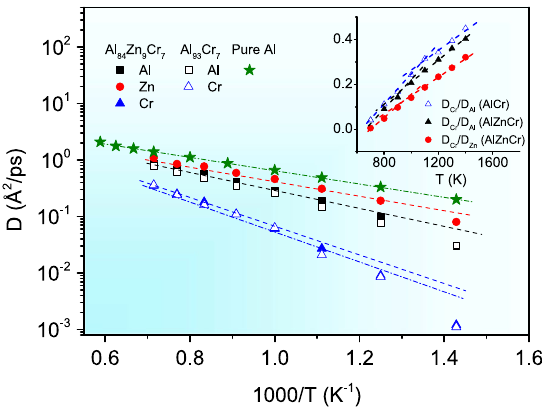
Fig. 1 Arrhenius plot of Al and Zn self-diffusion coef fi cients for the Al − Cr binary alloy as well as Al, Zn, and Cr self-diffusion coef fi cients for the Al − Zn − Cr ternary alloy. The simulation data for pure liquid Al is also included for comparison. Dashed lines are the corresponding Arrhenius fi t in the high-temperature range. The inset shows the temperature evolution of the ratio of the self-diffusion coef fi cients D Cr / D Al in the Al − Cr binary alloy as well as the D Cr / D Al and D Cr / D Zn in the Al − Zn − Cr ternary